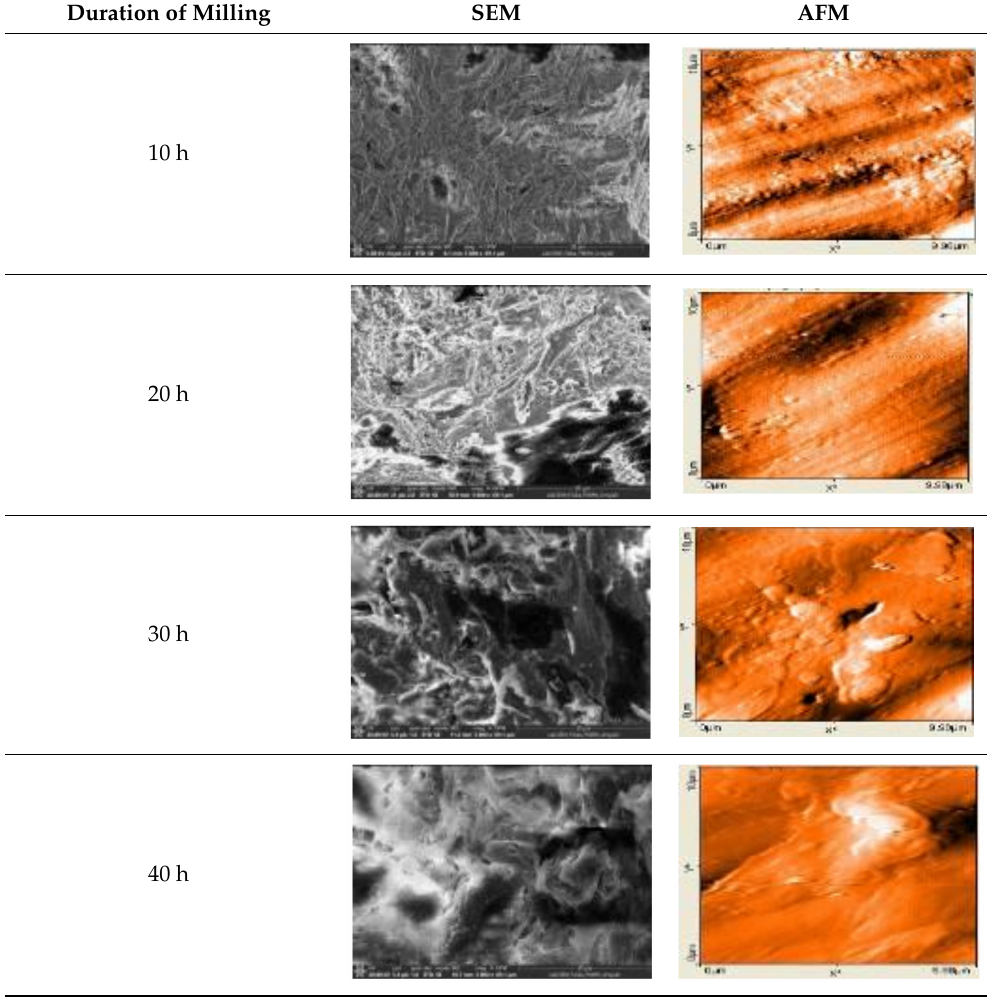
Table 8. SEM and AFM images for various milling times, 30 wt.% of PP. Duration of SEM Milling